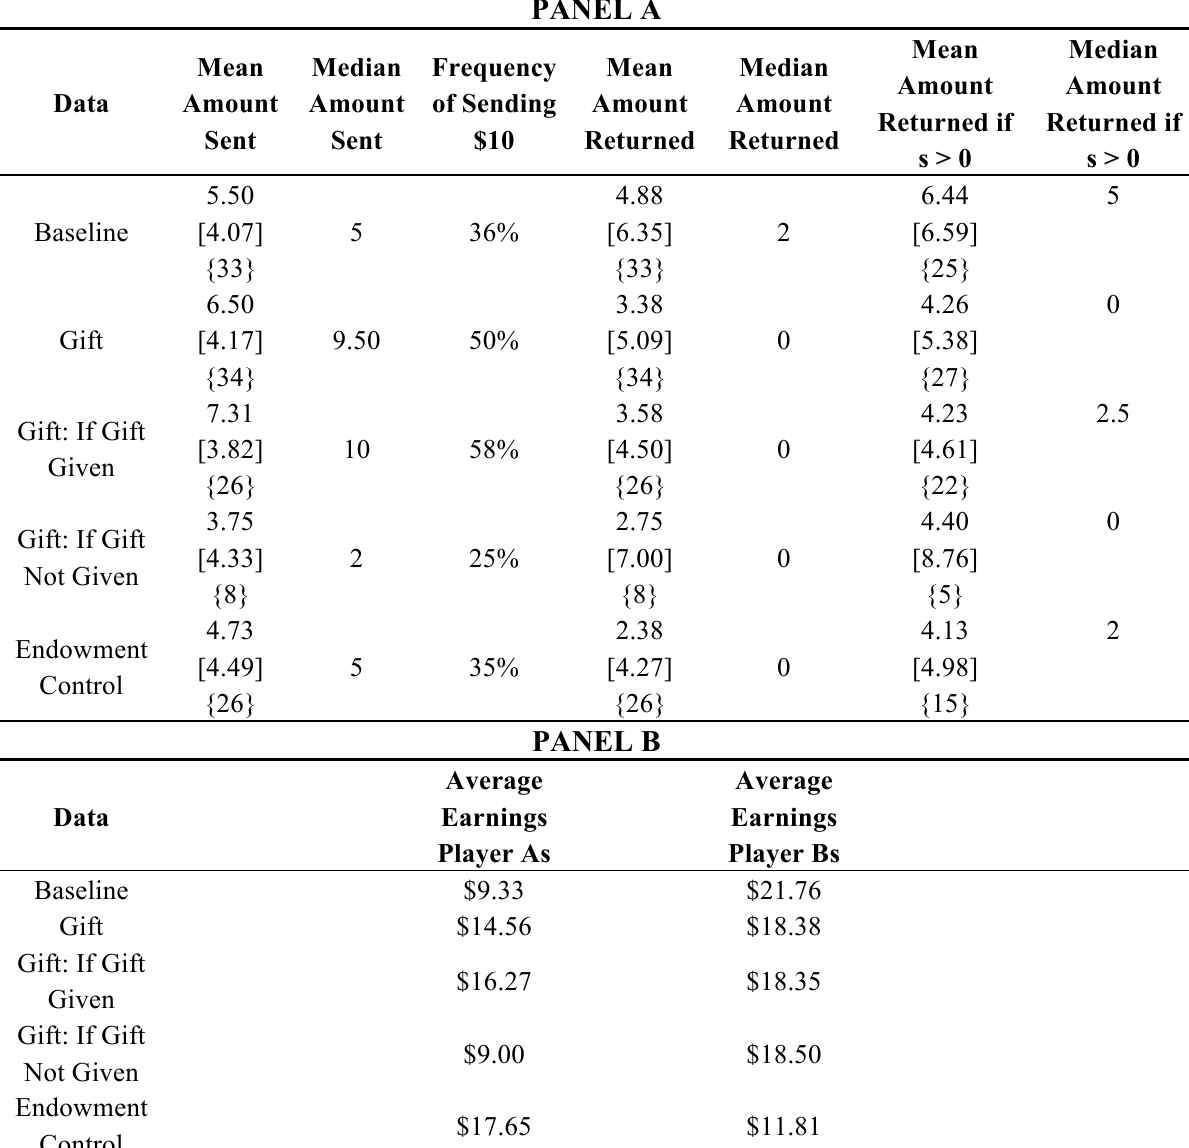
Table 1. Summary